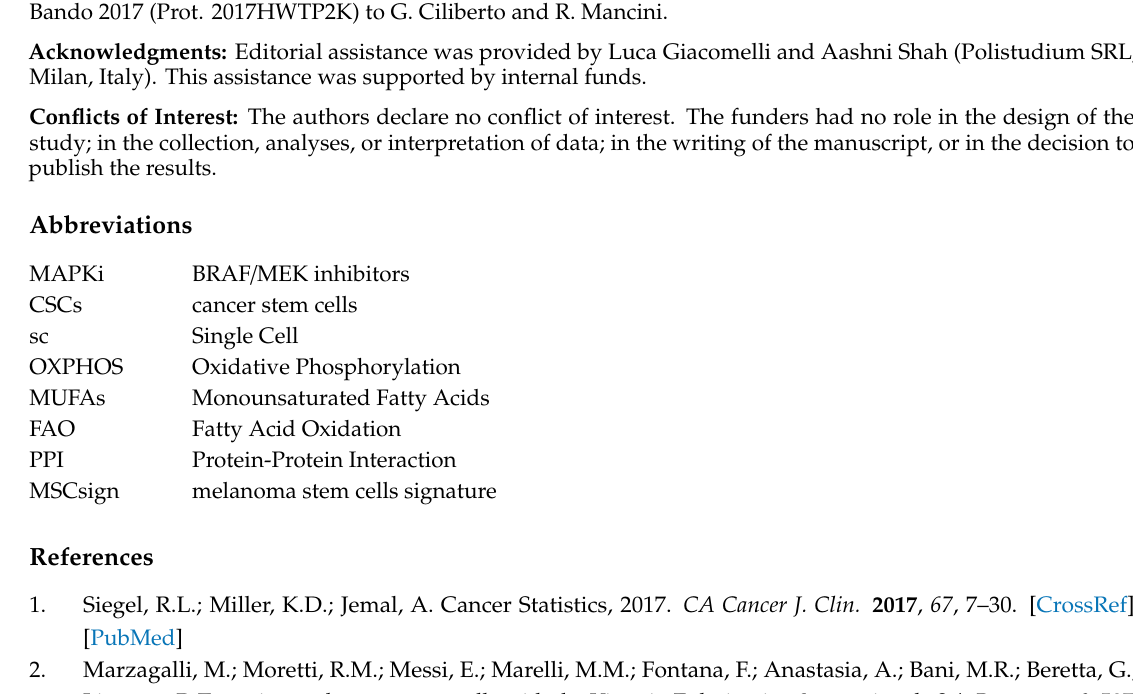
Table S1. Enrichment analyses of Gene Ontology, KEGG and Reactome on the list of 25 top genes performed using STRING online database. Table S2. Gene expression levels of “MSCsign” normalized considering the maximum median expression value coming from SKCM dataset. Table S3. Raw data of gene expression levels obtained from https: // www.cbioportal.org / . Table S4. OS data obtained from https: // www.cbioportal.org /